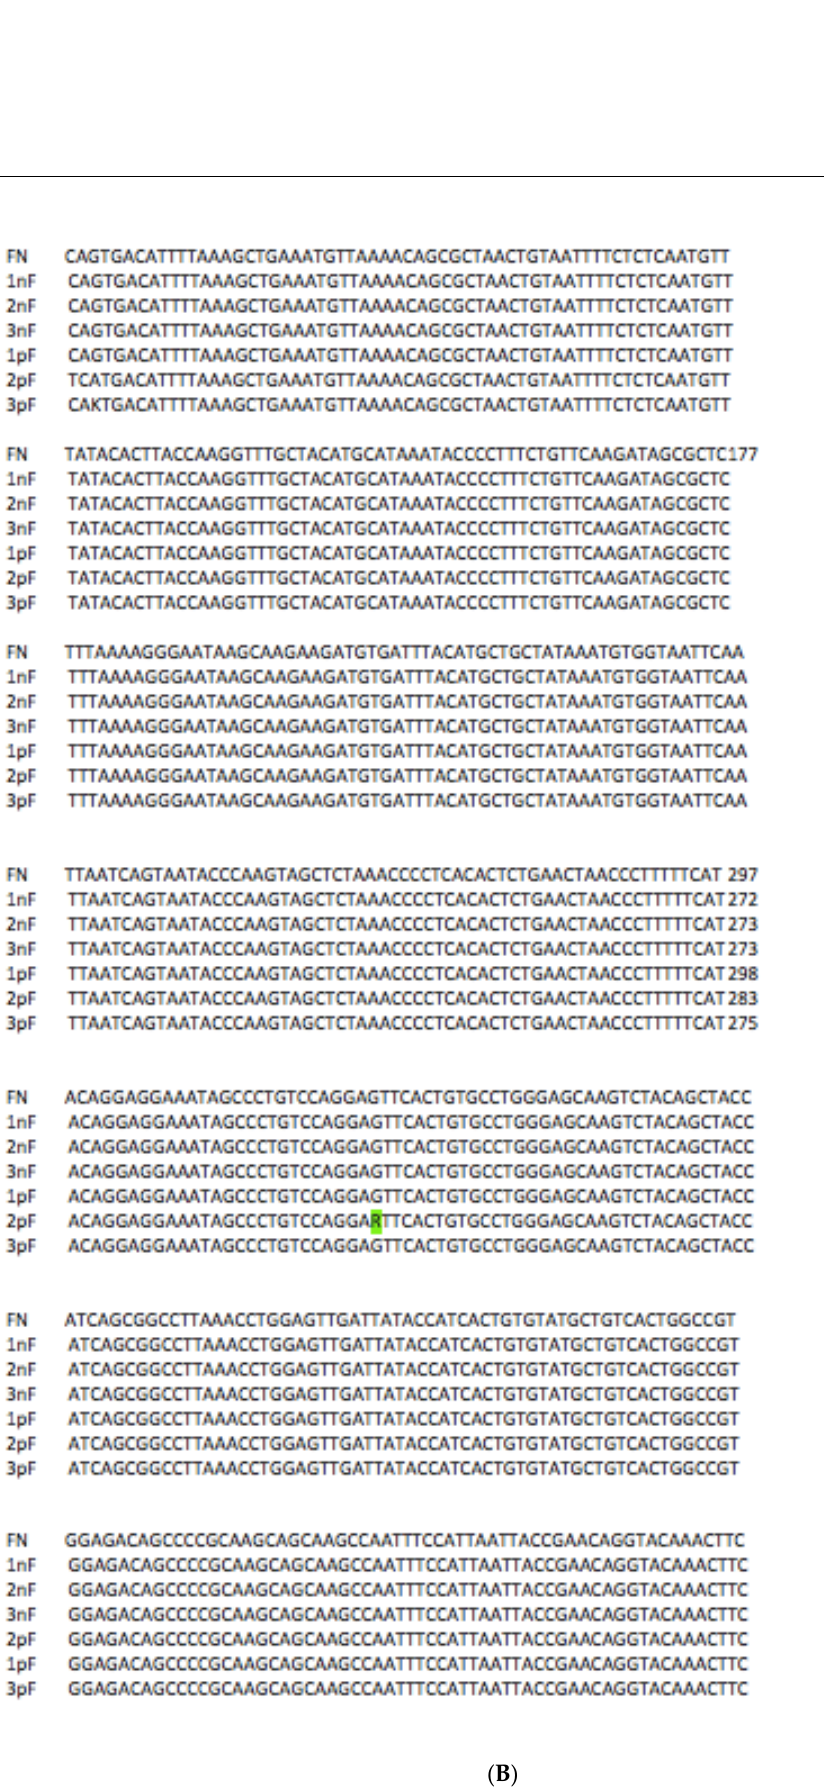
Figure 2. ( A ) Sequencing result of the DNM2 gene fragment. Samples 1nD, 2nD, and 3nD are healthy patients; 1pD, 2pD, and 3pD are patients with pathology. SNPs and transversion are highlighted in green. ( B ) Sequencing result of the FN gene fragment. Samples 1nF, 2nF, 3nF are healthy patients; 1pF, 2pF, 3pF are patients with pathology. SNPs are highlighted in